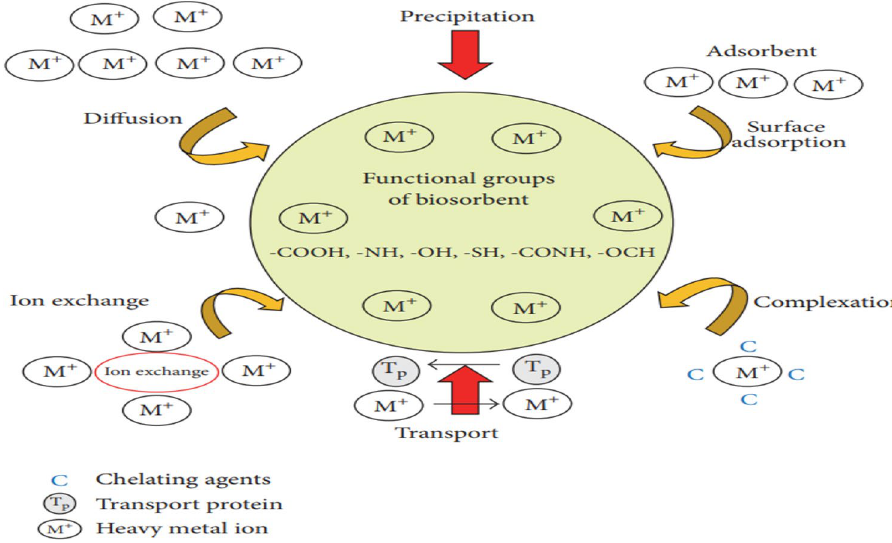
Fig. 7 Adsorption mechanisms created based on research by Mathew et al.